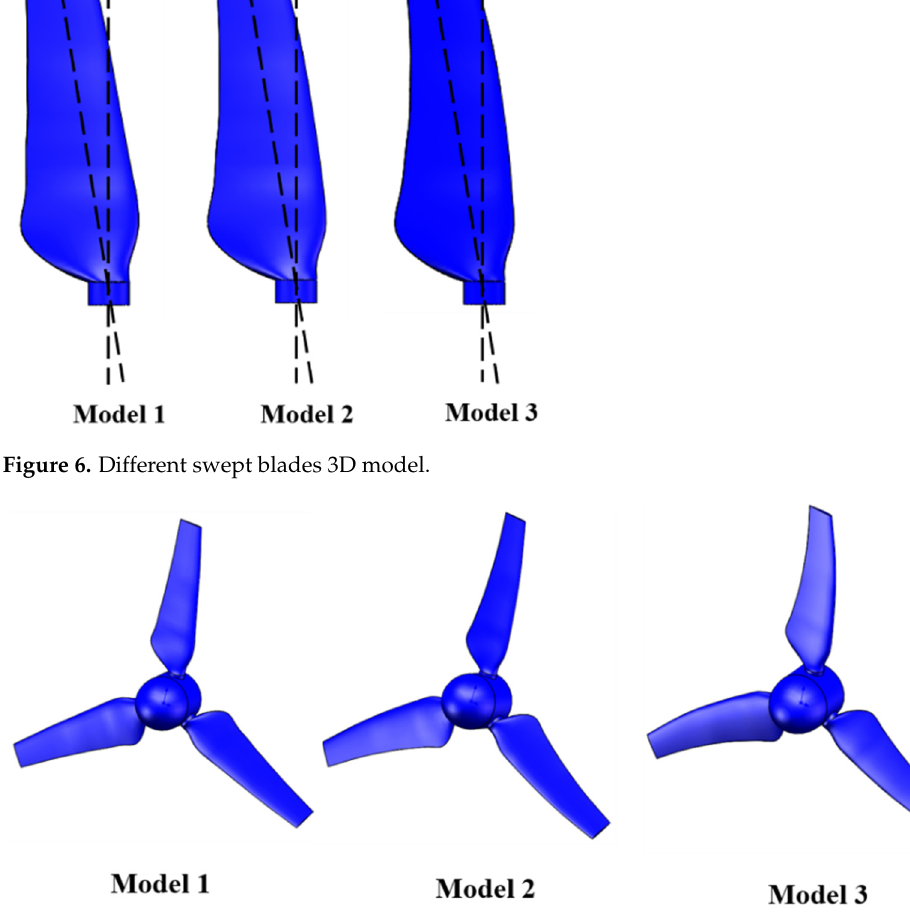
Figure 7. Rotor overall 3D model.